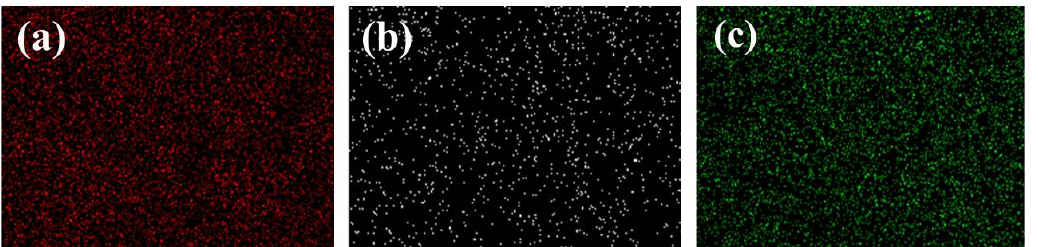
Figure 2. The EDS elemental mapping of ( a ) Zr, ( b ) Mg, and ( c ) O distribution of the Zr–Mg mixed oxide aerogels with Zr/Mg molar ratio of